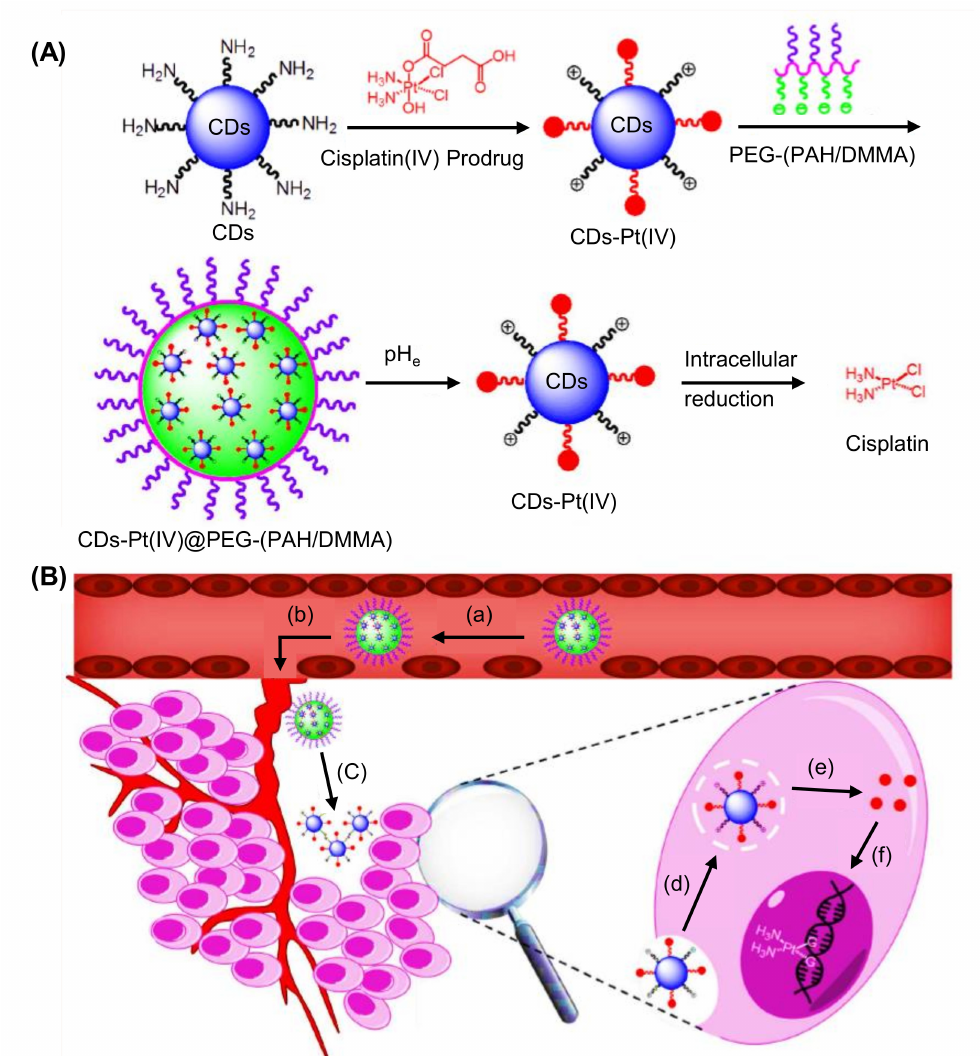
Figure 24. Graphical representation of ( A ) the synthesis and ( B ) the drug delivery system of a charge- convertible CD-based nanocarrier, i.e., CDs–Pt(IV)@PEG-(PAH/DMMA). Reprinted from [302], with permission from American Chemical Society, 2016. DMMA: dimethyl maleic acid; PAH: poly- acrylamide hydrochloride; PEG: polyethylene glycol; pH e : tumor extracellular pH. (a): Prolonged circulation time; (b) enhanced permeation and retention effect; (c) response to tumor extracellular pH; (d) endocytosis; (e) reduction; (f) DNA